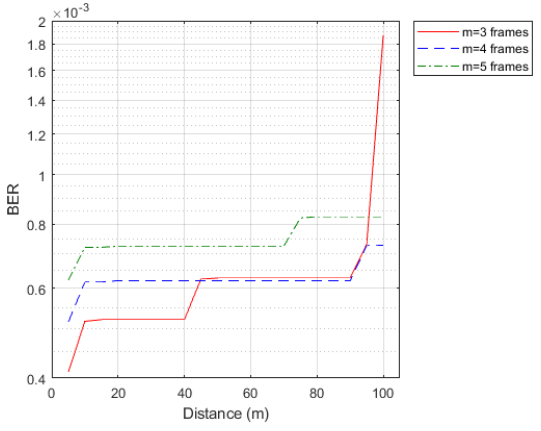
Figure 16. Communication BER for α =